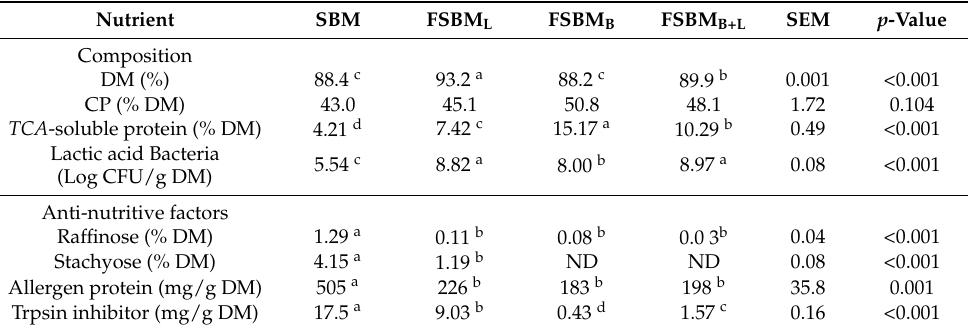
Table 1. Chemical composition of SBM and two-stage FSBM